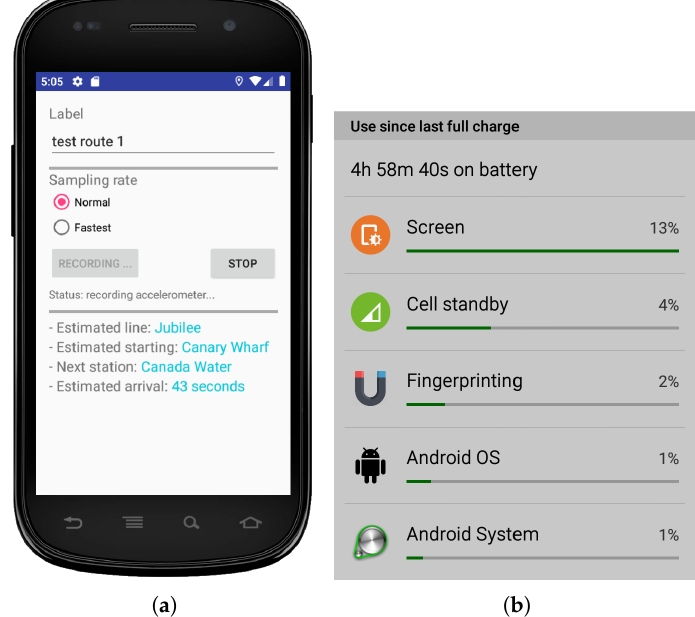
Figure 4. The Android app used to collect accelerometer data on the passenger’s phone: ( a ) The app interface and ( b ) The power